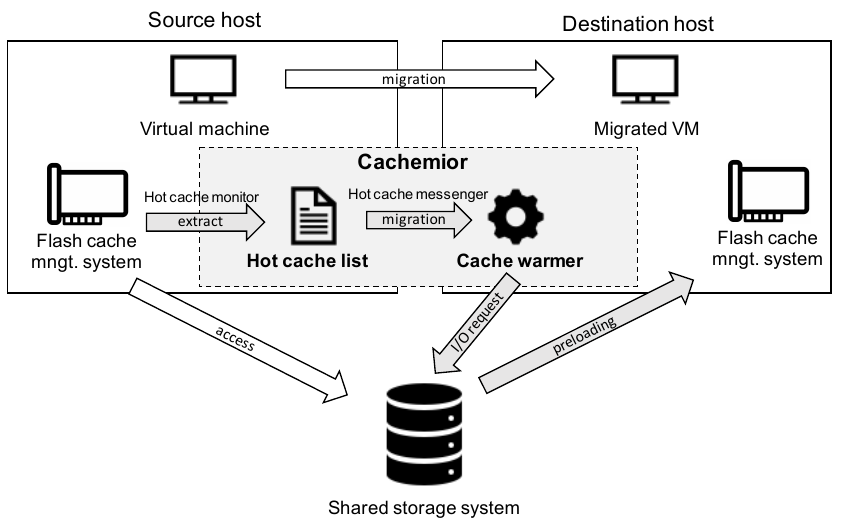
Figure 2. Components of Cachemior: Hot cache monitor, hot cache messenger, and cache